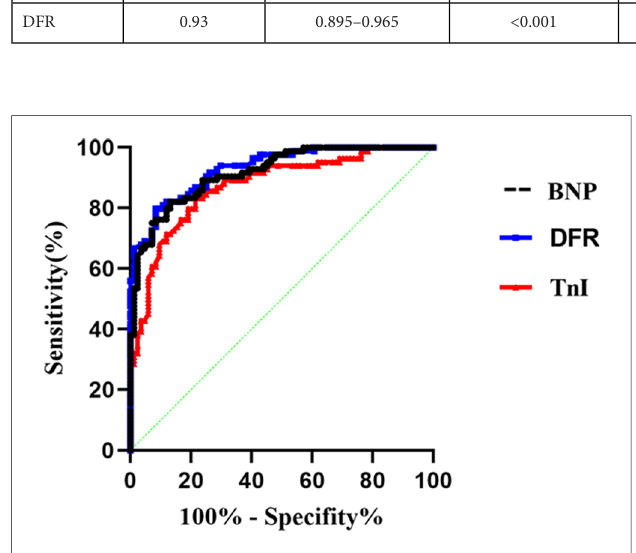
FIGURE 8 The ROC curve was used to analyze the serum BNP, TnI and DFR of APE